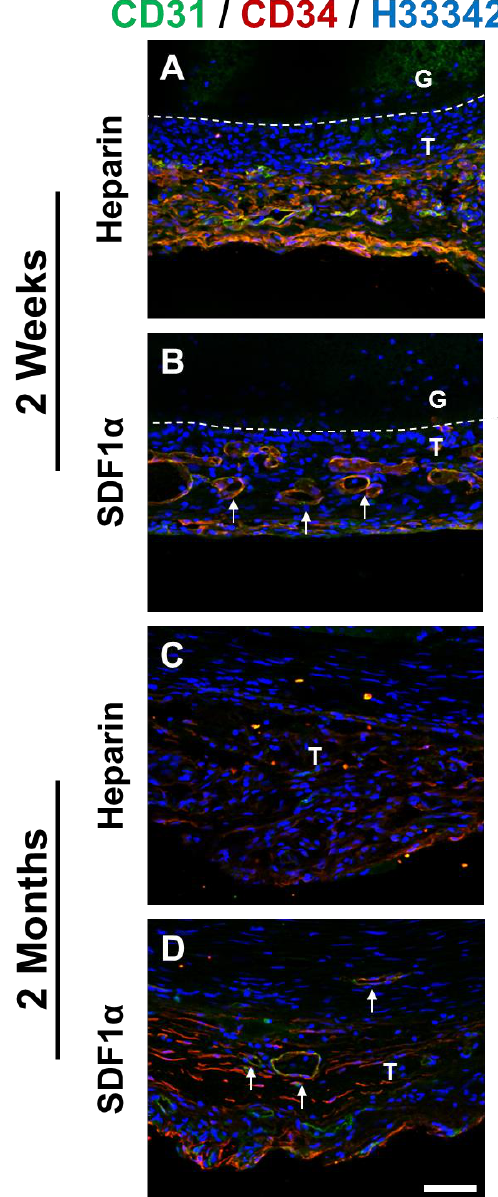
Figure 12. Identification and characterization of ECs and EPCs. Immunostaining for CD 31 ( green ) and CD34 ( red ) of the cross-section of heparinized and SDF-1α immobilized grafts at ( A , B ) 2 weeks and ( C , D ) 2 months after implantation. Nuclei were stained with Hoechst 33342 ( blue ). Dashed lines are used to distinguish the boundaries between G (graft), and T (surrounding tissues). Arrows indicate neovascularization on the outer surface of the grafts. Scale bar = 50 μm.